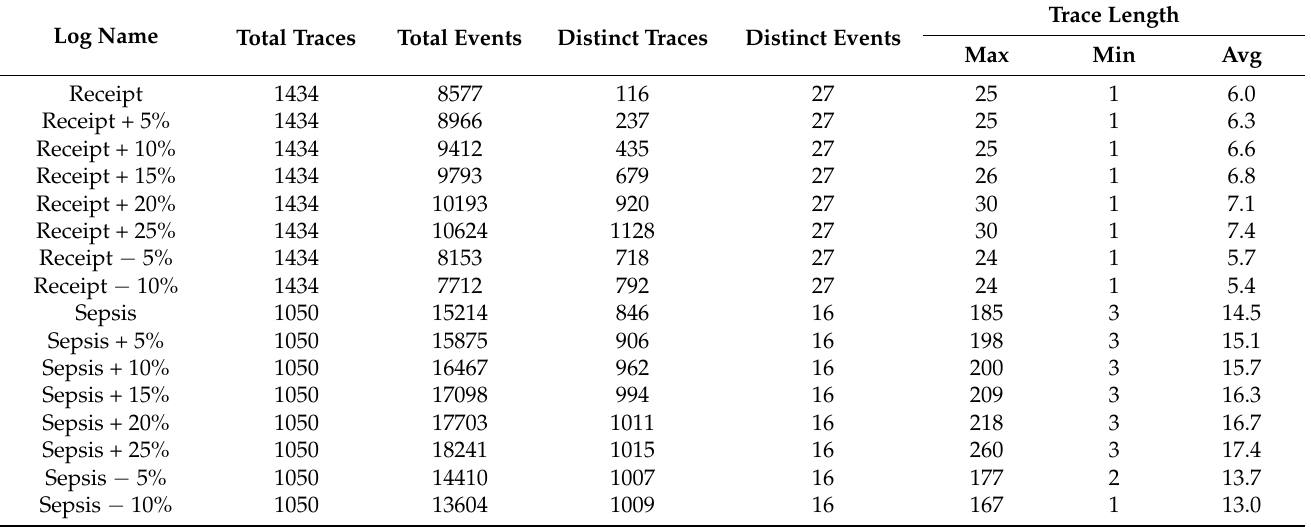
Table 1. Event log